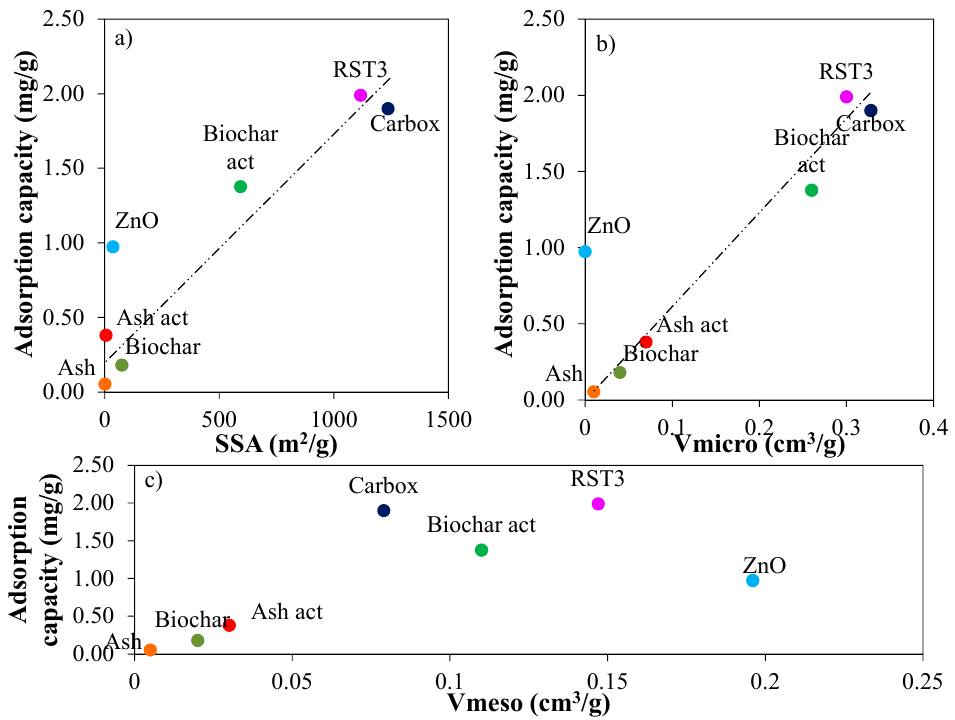
Figure 4. Adsorption capacity in relation with surface area and microporous volume: ( a ) SSA vs. Cads.; ( b ) Vmicro vs. Cads.; ( c ) Vmeso vs. Cads.